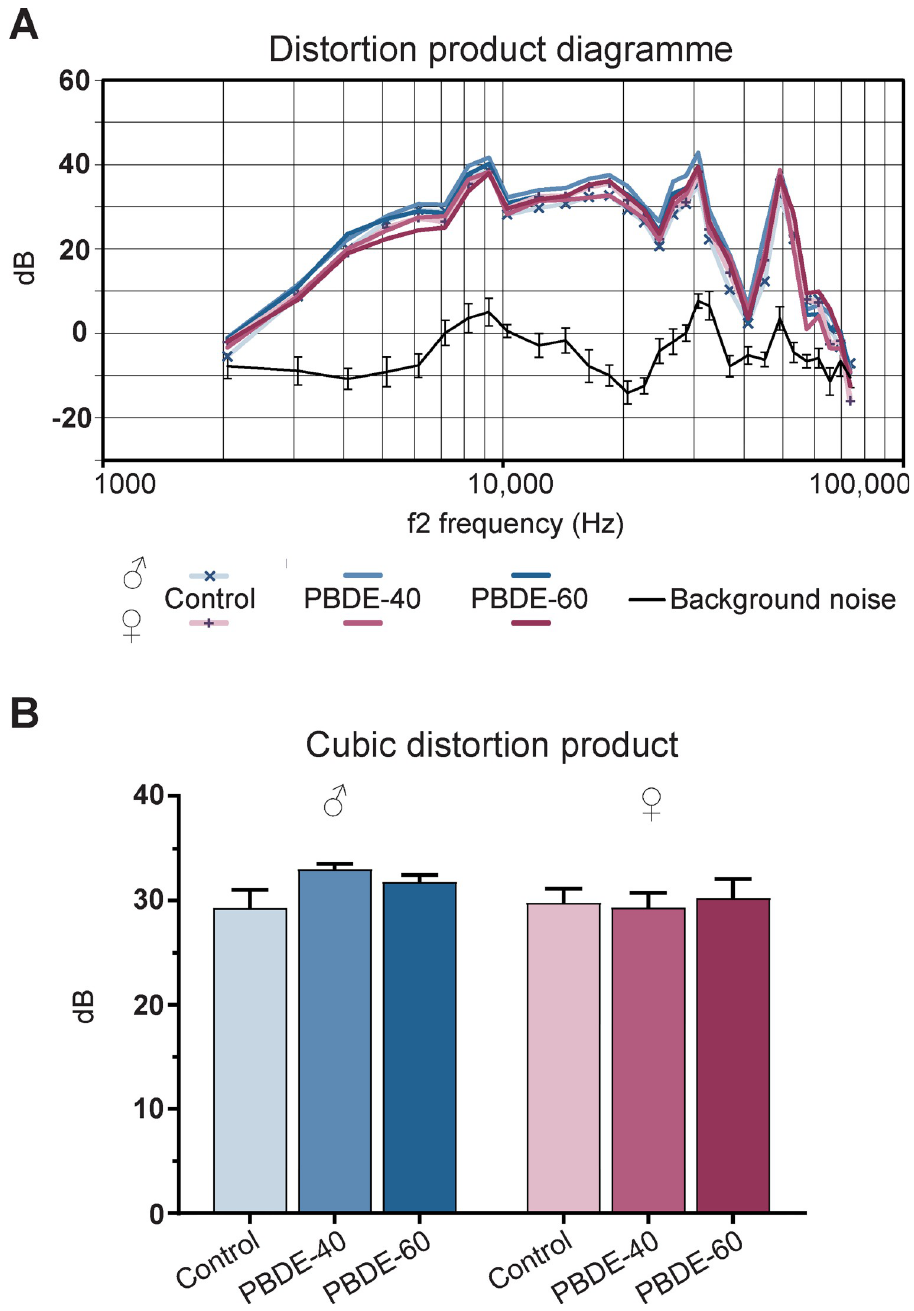
Fig 7. Hearing function in adult 7.5–8 months old male and female offspring exposed to PBDEs during development. (A) Distortion product diagram of cubic distortion product at all tested frequencies (2 to 70 kHz). Data represent group means, black curve represents background noise ± 95% confidence interval. (B) Average cubic distortion product for f2 at 4 and 32 kHz. PBDE: polybrominated diphenyl ethers (DE-71). n =